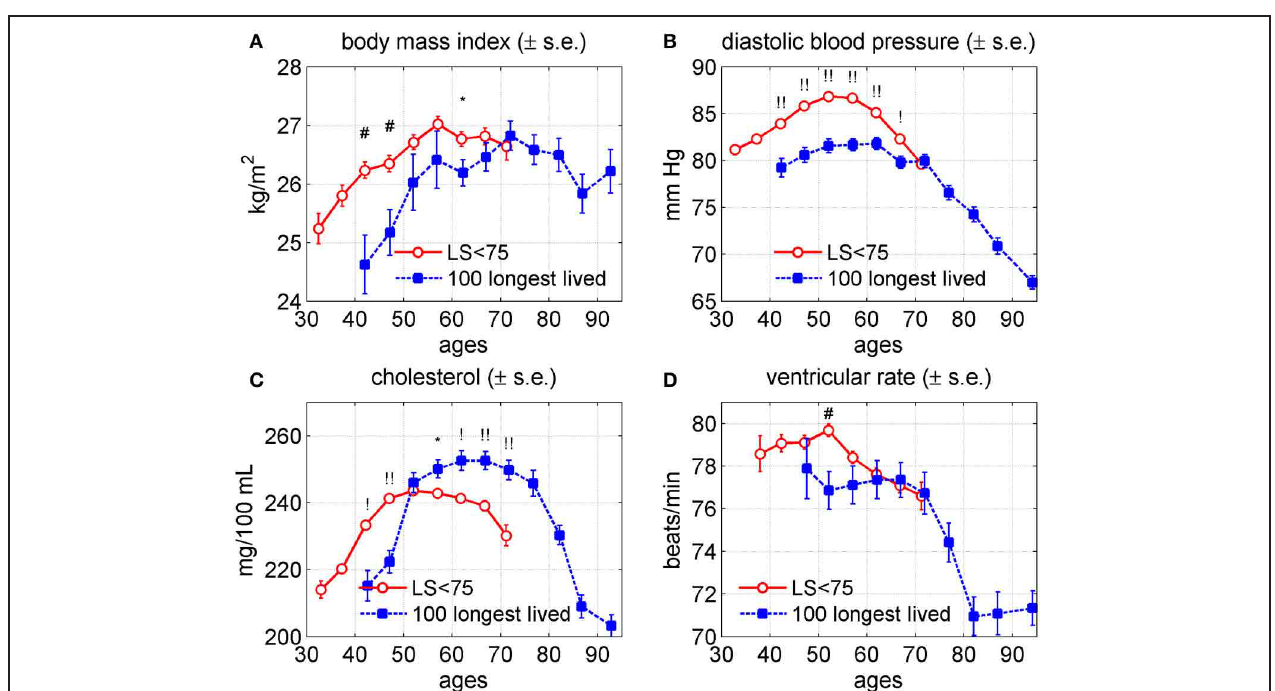
FIGURE 3 | Average trajectories ( ± standard errors) of four physiological variables in groups of short-lived individuals (“LS < 75,” i.e., those dying at ages 75 or earlier; censored individuals are excluded from this group) and 100 longest lived individuals in the Framingham Heart Study (original cohort, pooled data from